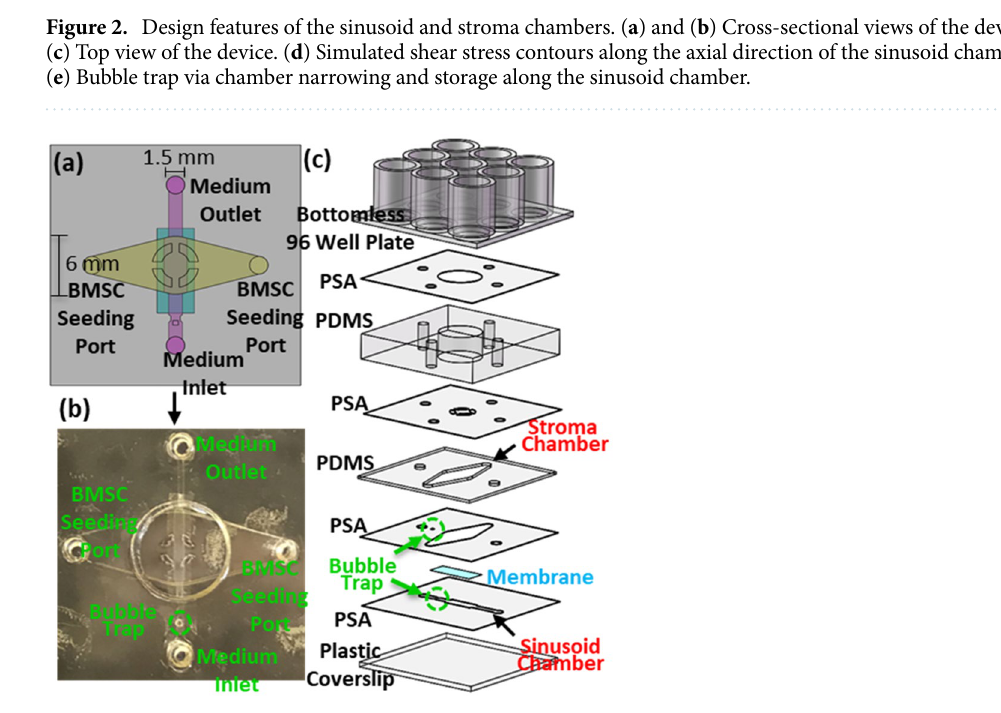
Figure 3. Device fabrication. ( a ) Schematic top view of one pair of the sinusoid and stroma chambers. ( b ) Picture of the actual device fabricated prior to assembly onto a bottomless 96-well plate. ( c ) Schematic illustration of the layer-by-layer assembly used to produce the microfluidic